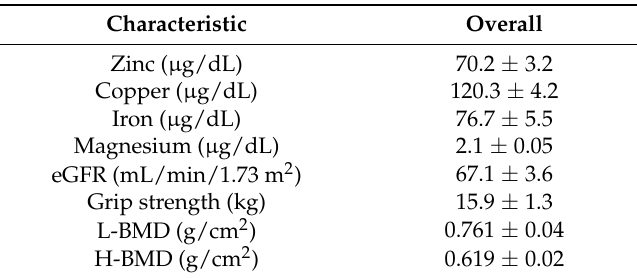
Table 1. Baseline values prior to treatment ( n =